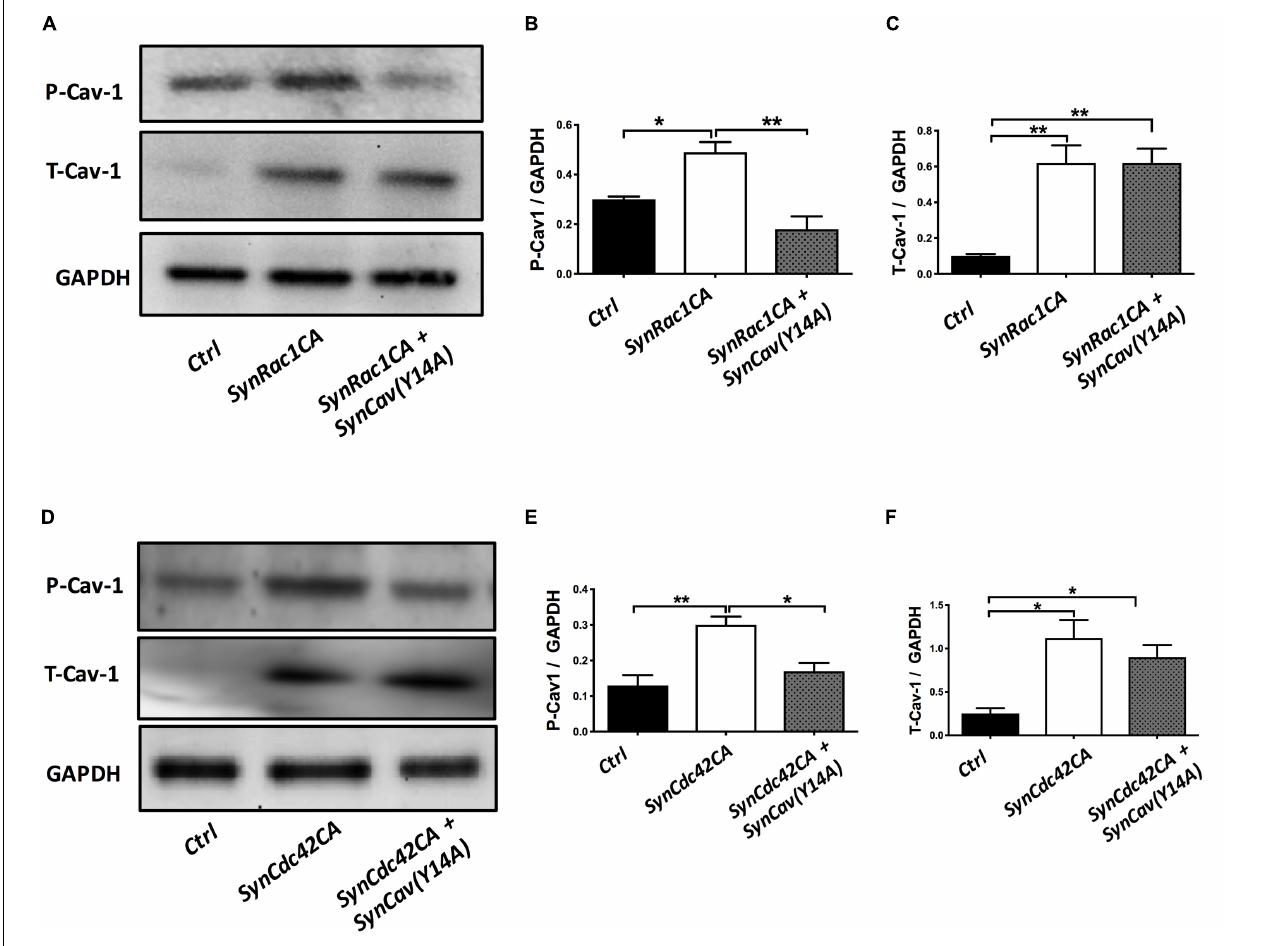
FIGURE 8 | SynCav1(Y14A) prevents SynRac1CA and SynCdc42CA -mediated increased P-Cav-1 expression in NPCs. NPCs were treated with vectors (2 × 10 9 IU/ µ l) as indicated on day 3 and WB was performed on week 2 to assay for P-Cav-1, T-Cav-1, and GAPDH. (A) Representative WB images of Ctrl , SynRac1CA, or SynRac1CA + SynCav1(Y14A) treated NPCs; Quantitation of P-Cav-1 and T-Cav-1 expression are shown in (B , C) , respectively. (D) Representative WB images of Ctrl , SynCdc42CA, or SynCdc42CA + SynCav1(Y14A) treated NPCs; Quantitation of P-Cav-1 and T-Cav-1 expression are shown in (E , F) , respectively. Data are expressed as the mean ± SE ( n = 3, ∗ p < 0.05, ∗∗ p < 0.01, One-way